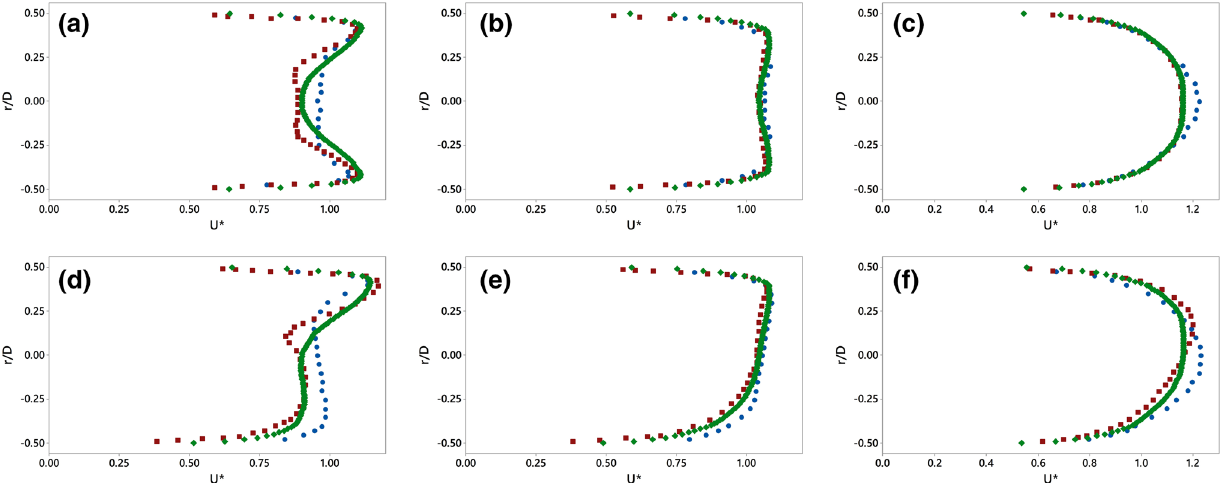
Fig. 2 Numerical and experimental comparison of non-dimensional velocity, U * = U / U m ( U m is the average velocity). Along cross or 0° lines for a 3.5 D , b 10 D , and c 50 D . Along symmetric or 90° lines for